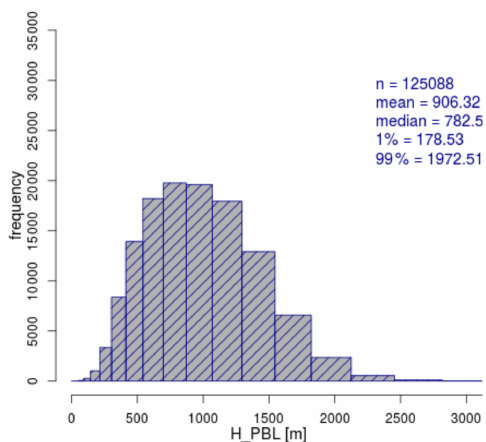
Figure A3. Boundary layer height histogram for convective boundary layers (surface temperature greater than 2m temperature).